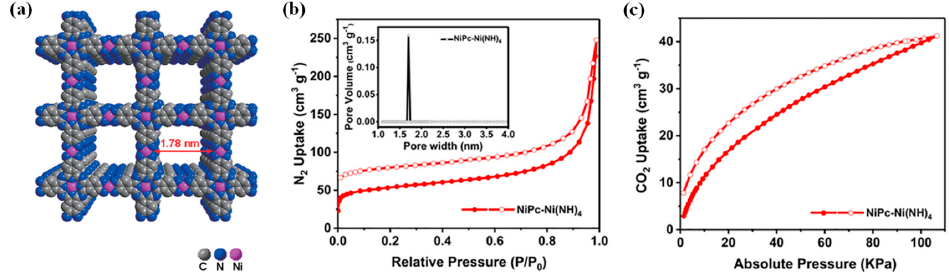
Figure 6. ( a ) Structure of NiPc − Ni(NH) 4 ; ( b ) N 2 adsorption/desorption isotherms of NiPc − Ni(NH) 4 ; ( c ) CO 2 adsorption isotherms of NiPc − Ni(NH) 4 [58]. Reprinted with permission from Ref. [58].